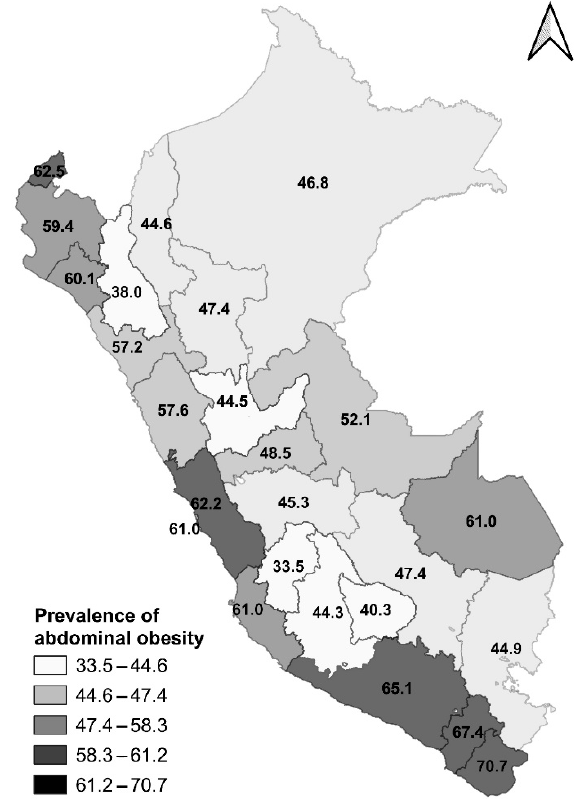
Figure 2. Prevalence of abdominal obesity according to the departments of Peru.